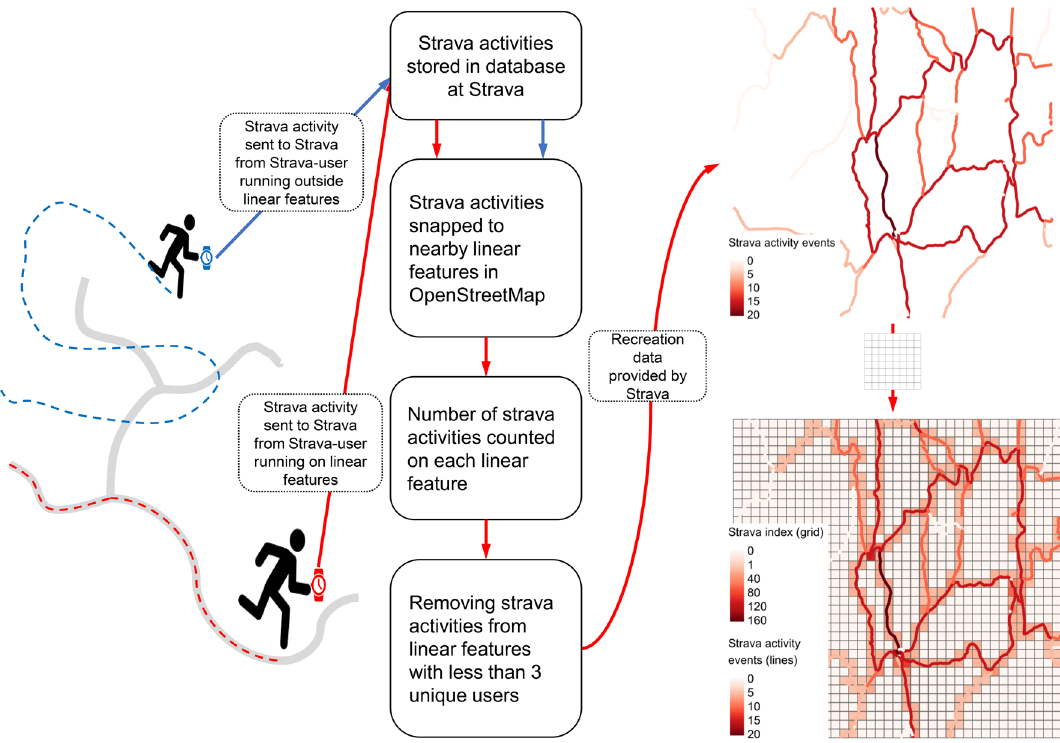
Strava-users, where the blue is from a user running outside linear features and the red is from a user running on linear features. The activity event from the blue user cannot be snapped to linear features in OSM and is removed during processing. The map to the top right represents a network of linear features and associated Strava activity events. The legend shows how many activity events are associated with the different paths (note that they are rounded to nearest multiple of 5). The map in the bottom right represents the same network after the number of Strava activity events for every linear feature in each grid cell have been